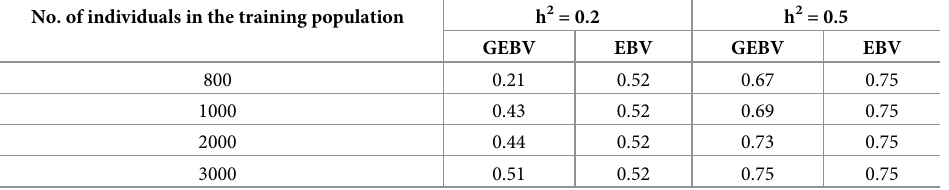
Table 3. Accuracies of GEBVs using a 60K SNP panel and a different number of individuals (800, 1,000, 2,000 and 3,000) in the training population for low (h 2 = 0.2) and high (h 2 = 0.5) heritability traits, compared with the accuracy of equivalent EBVs.